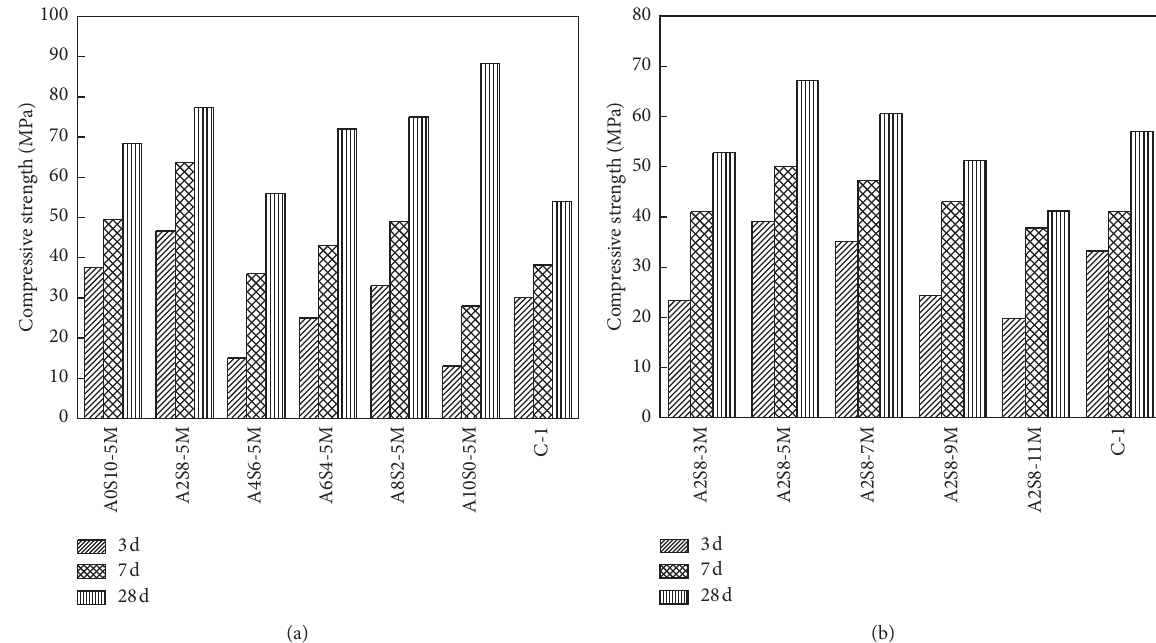
Figure 5: AAS compressive strength with different NaAlO 2 dosages and Na2O contents and cement. (a) Different NaAlO 2 dosages and cement and (b) different Na2O contents and